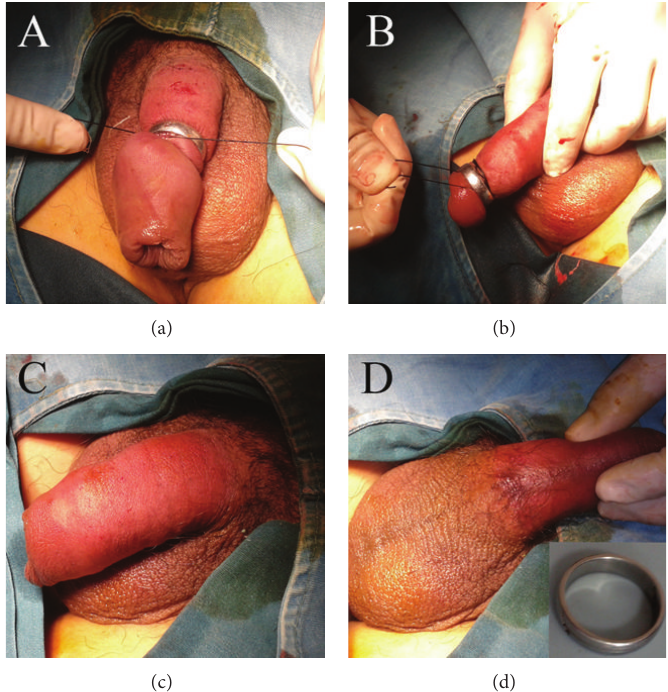
Figure 2: Surgical photograph of the surgical procedure. (a) Ligature of silk string is passed proximally through the metallic ring. (b) The silk was wound around the penis 10 to 15 times just below the metallic ring. The metallic ring is then pushed distally 3 cm down the penis. (c, d) There is no damage to the dorsal and ventral part of the penis. The ring was removed intact from the penis.